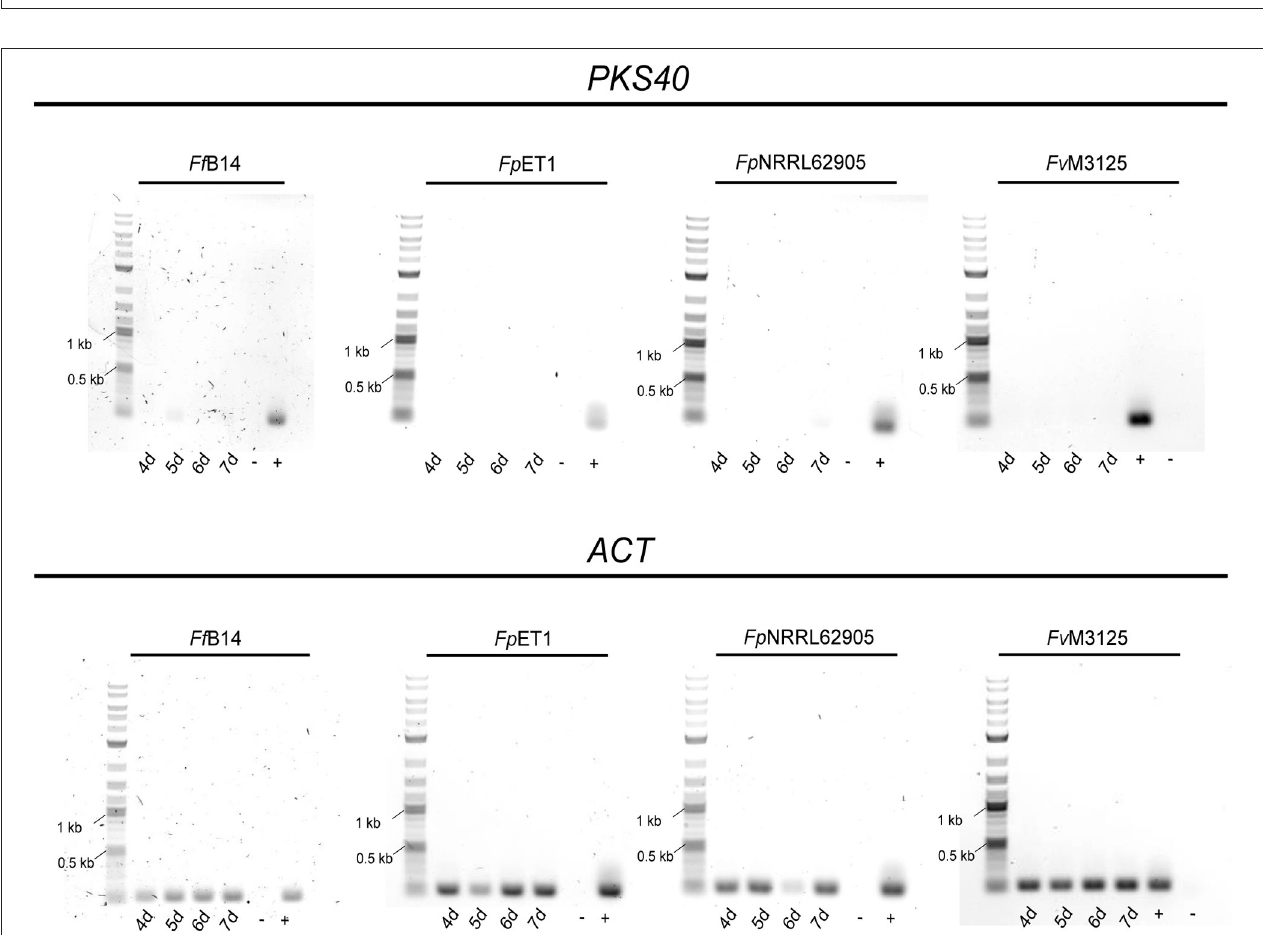
FIGURE 9 | arrows are designated putative cluster genes. Black arrows represent genes that are orthologes in other species and grey arrows show genes which do not have closely related orthologes. 9 designates a pseudogene. (B) Table of several other Fusarium species from the FFSC and other Fusarium species complexes